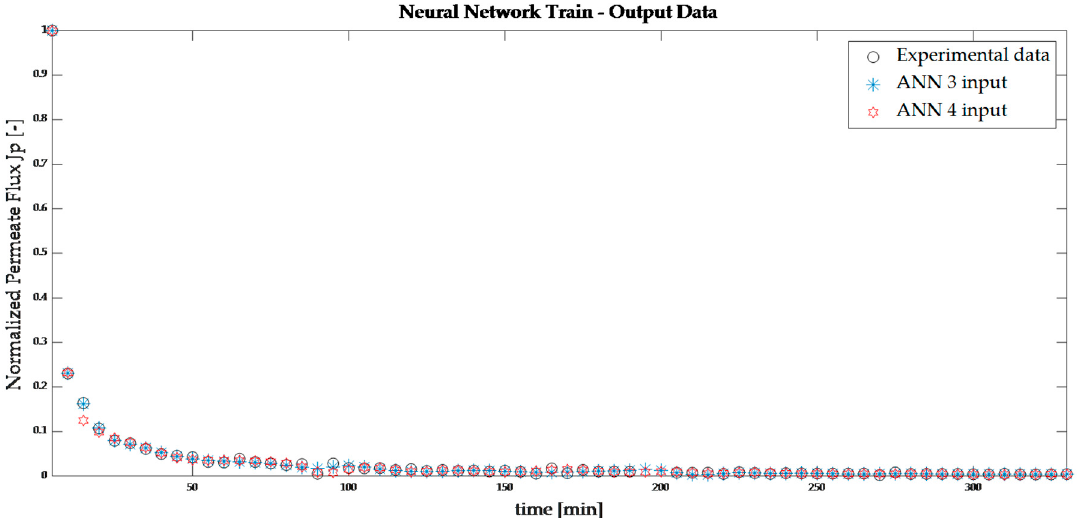
Figure 5. Post training analysis—comparison between experimental data and ANNs developed with three and four inputs.